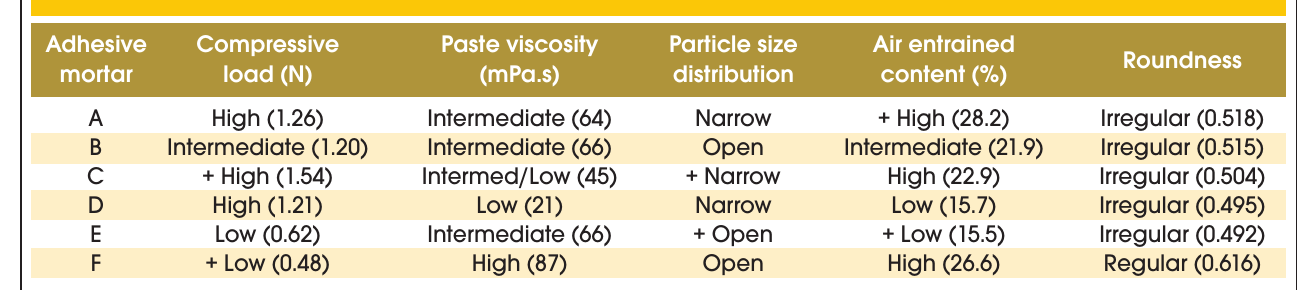
Table 6 – Summary of the adhesive mortars